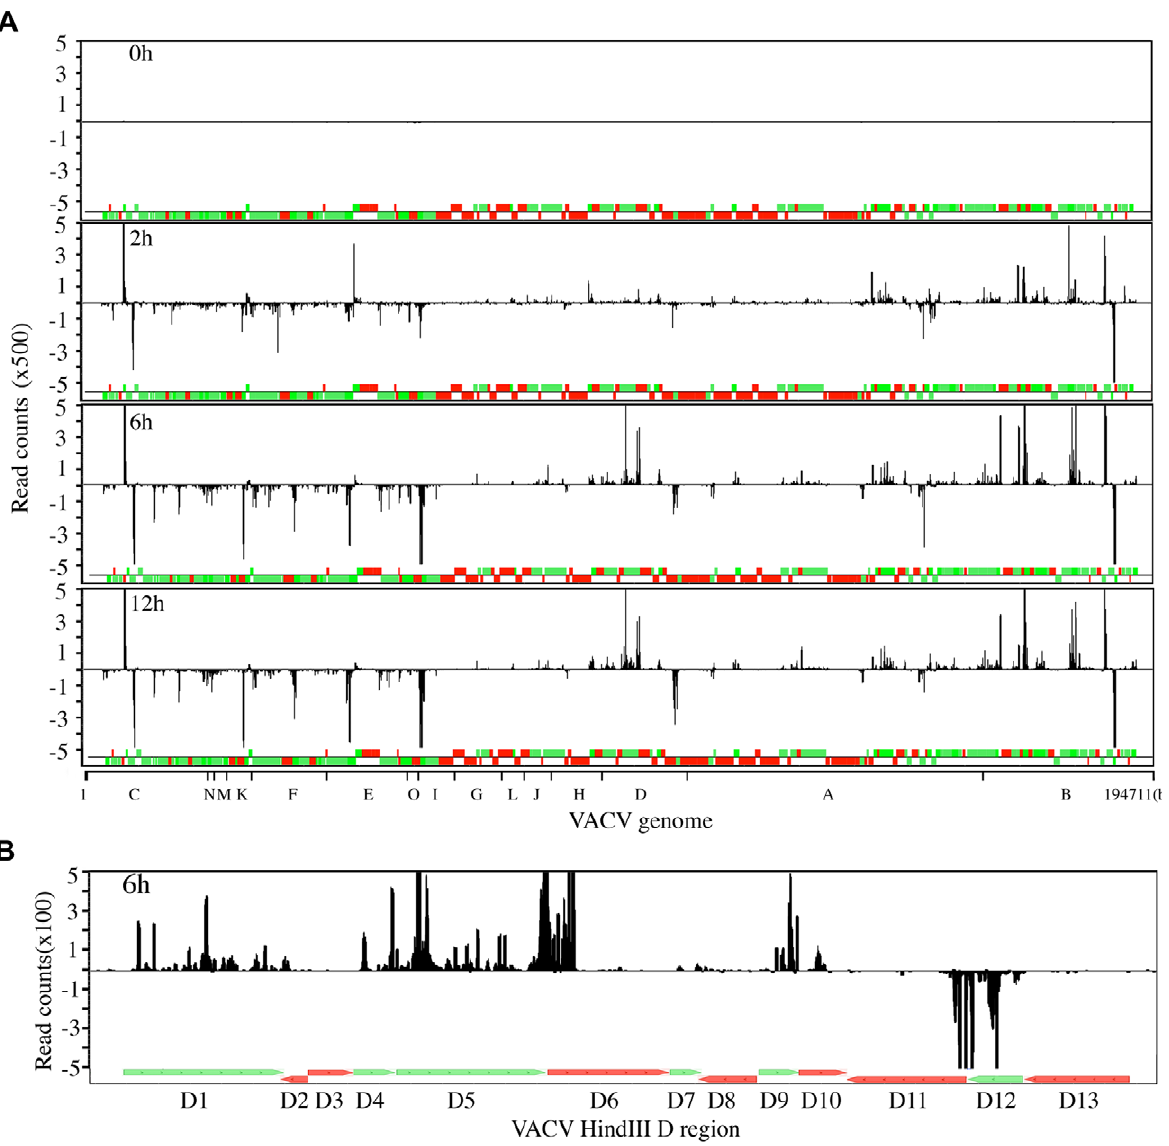
Figure 7. VACV genome-wide transcriptome maps of S2 cells. A ) The number of viral sequence reads per nucleotide was determined as indicated in the legend to Fig. 6 and displayed over the entire VACV genome with early and post-transcriptional ORFs in green and red, respectively. The counts above the line map to the upper (rightward) strand and counts below the line map to the lower (leftward) strand of the VACV genome. The highest read counts are off-scale in the 2- to 12-h samples for display purposes. The counts were normalized by the total reads of the samples and those duplicated because of their location within the inverted terminal repetition were divided by 2. The HindIII restriction map of the VACV genome is shown at the bottom for reference purposes. B ) The HindIII D region from the 6 h time point in panel A has been